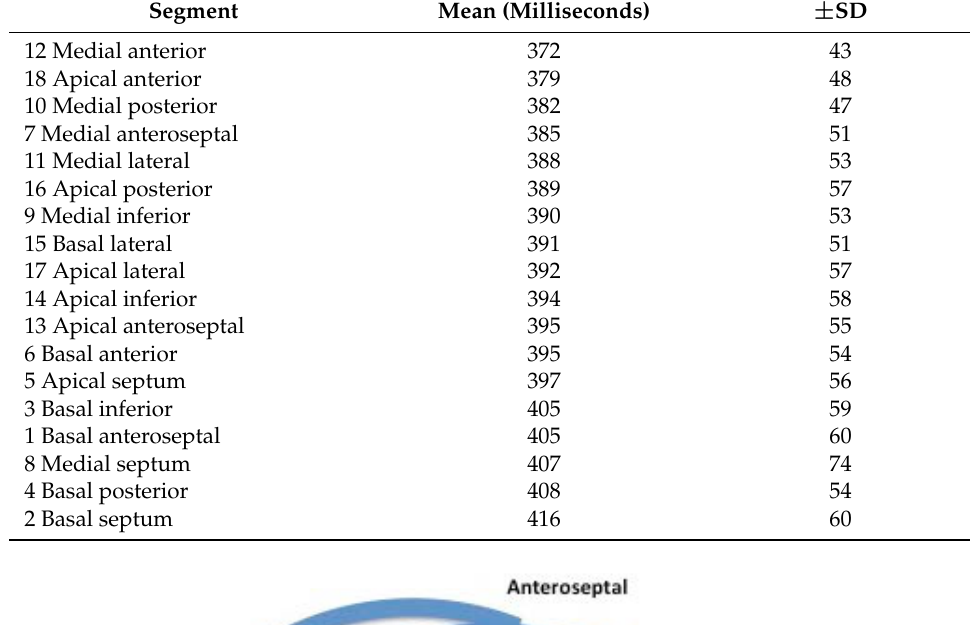
Table 4. Segmental sequence in ascending order: time to the latest longitudinal deformation (LD).